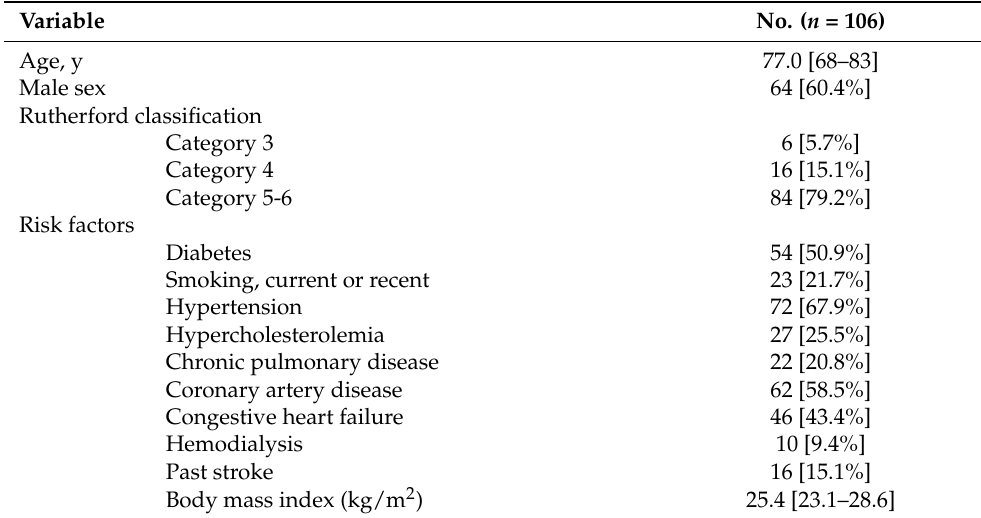
Table 1. Patient